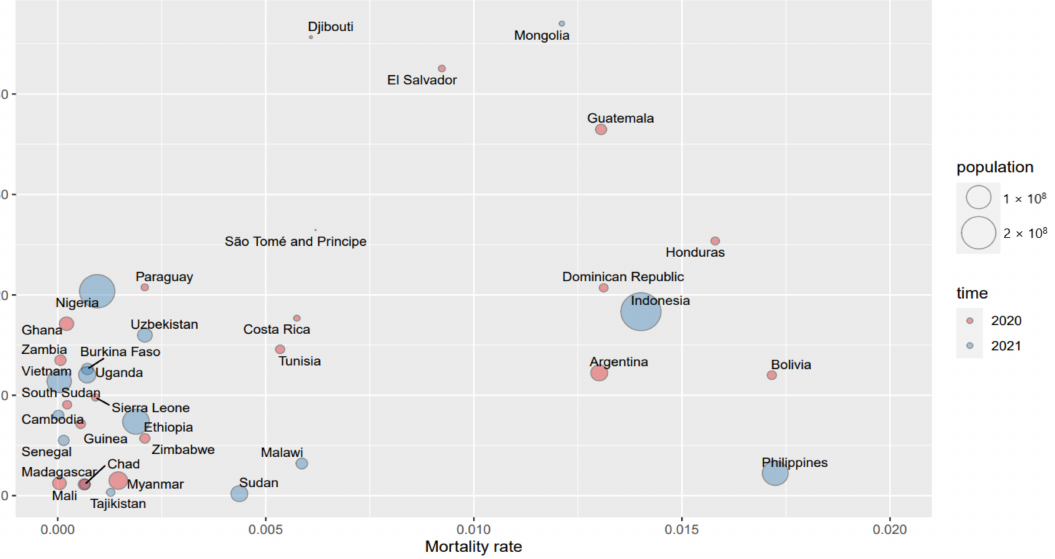
Figure 5. The pattern of the mortality rate and traditional appliances in children’s education since school closure.